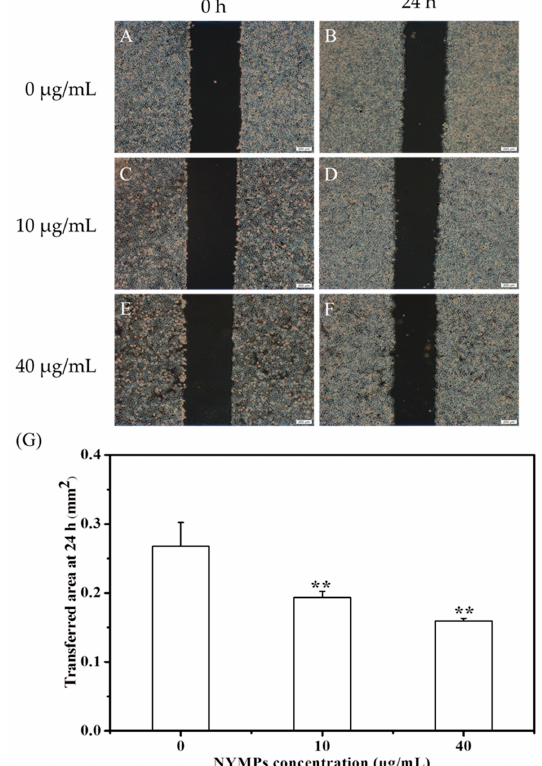
Figure 5. Effects of NYMPs on cell migration of human breast cancer MCF-7 cells (Magnification × 40). ( A , B ) Images of cells treated without NYMPs. ( C , D ) Images of cells treated with 10 µ g/mL NYMPs. ( E , F ) Images of cells treated with 40 μ g/mL of NYMPs. ( G ) Migrated ability. Each value represents the mean ± standard deviation ( n = 3). ** p < 0.01 indicated statistically significant differences versus control group.